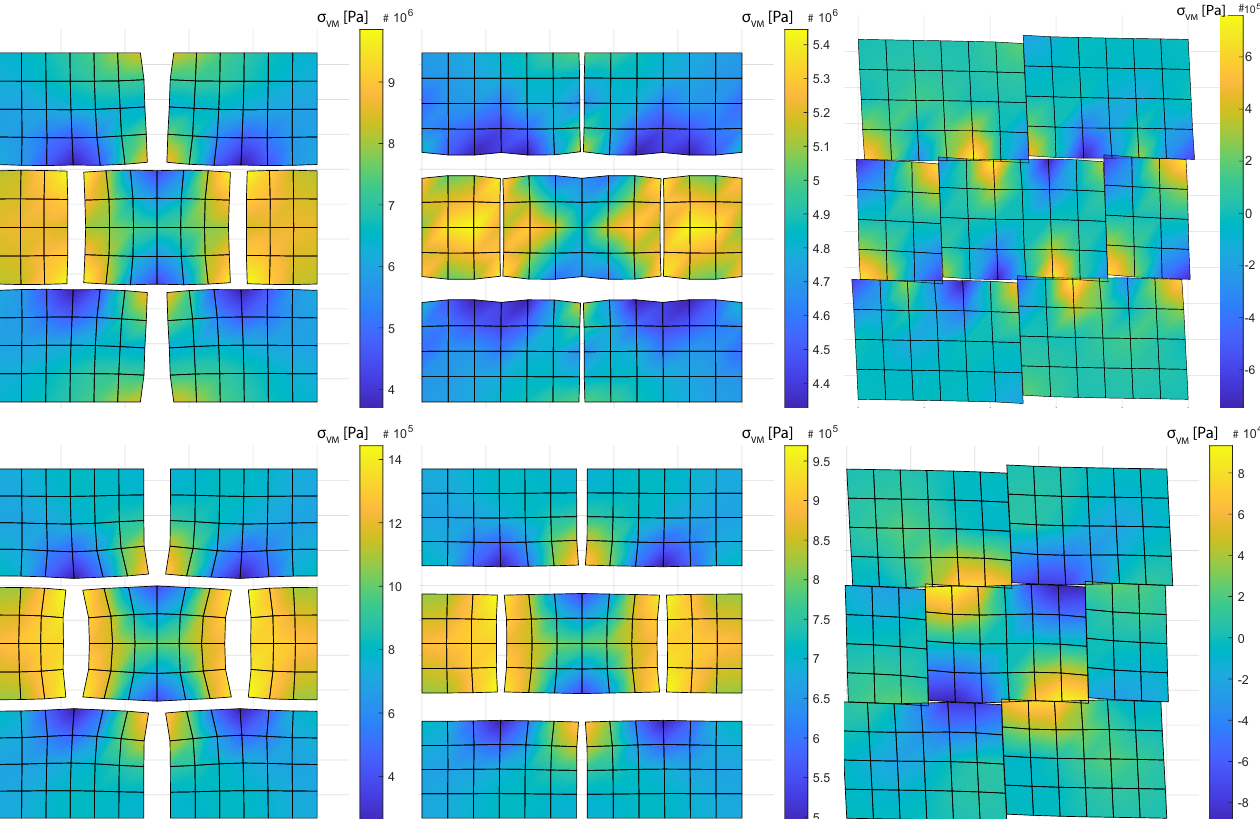
Figure 4. Configurations for a macro deformation (cid:101) = 0.005 in all DoF, including crack pore pressure. Colormap represents von Misses strain in Pascals. Crack stiffness: G = 10 13 GPa ( top ) and G = 10 14 GPa ( bottom ). Deformation magnification: 50 ×